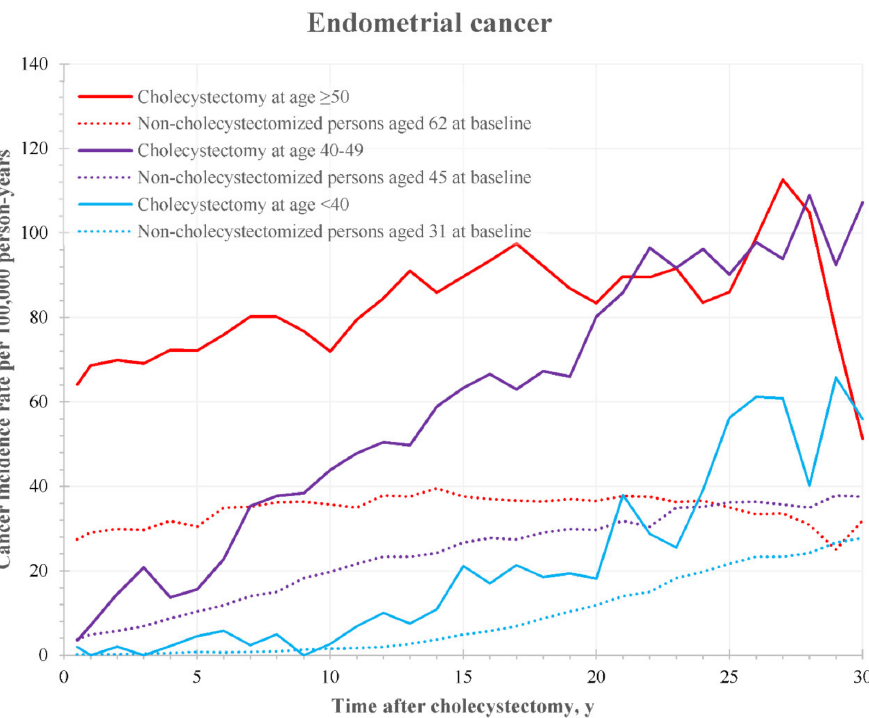
Figure 3. Incidence rate of endometrial cancer after cholecystectomy by time after surgery and pa- tient’s age at the operation. Dotted lines represent the corresponding rates for non-cholecystectomized individuals with an age at baseline equal to the median age in the groups of cholecystectomized